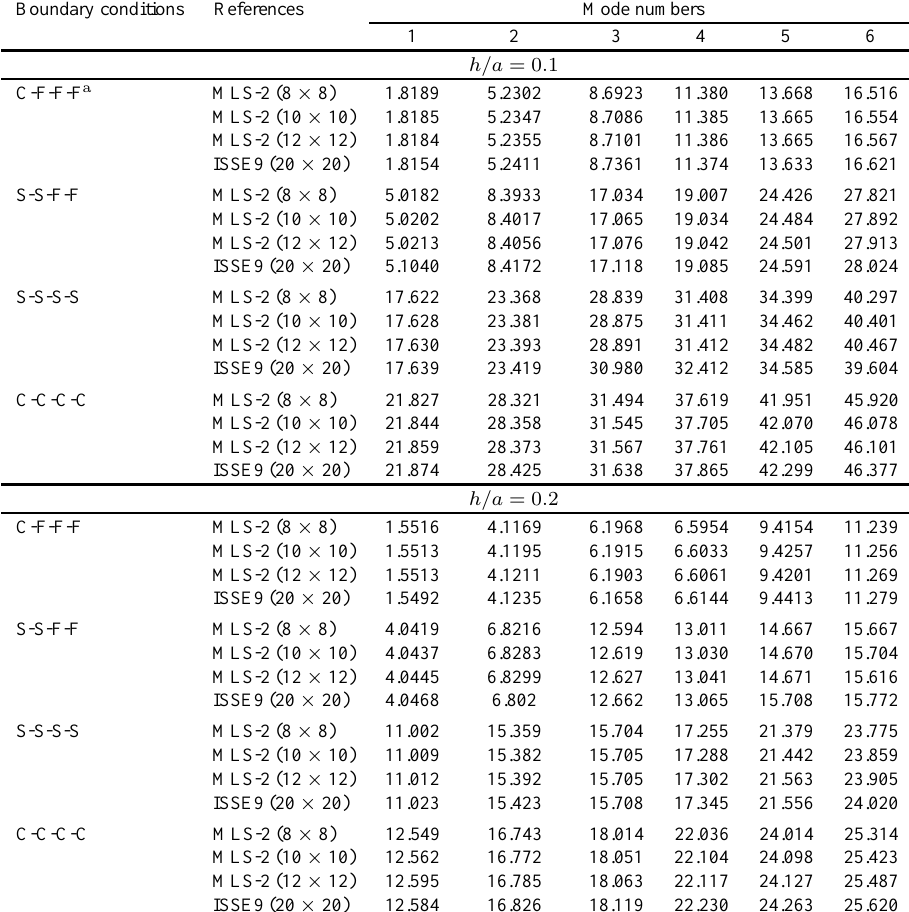
(cid:1) Table 6 ρ/E 2 h 2 ) of an angle-ply (45/-45/45) spherical shell panel (Fig. 2) having Frequency parameters ( ωa 2 different boundary conditions at the four sides ( R x /a = 3 . 0 , a/b = 1 , E 1 /E 2 = 25 , G 12 = G 13 = 0 . 5 E 2 , G 23 = 0 . 2 E 2 , ν 12 = 0 . 25